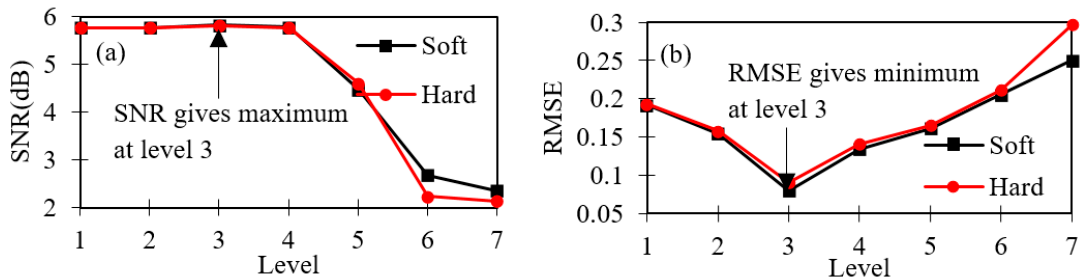
Figure 7. At each level of decompositions: ( a ) signal to noise ratio (SNR) values, ( b ) root mean square error (RMSE) values.